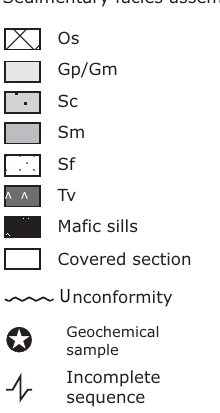
Figure 11. Synthetic diagram for the stratigraphy of the Imbert Fm in the Puerto Plata ophiolitic and Río San Juan complexes. See Fig. 2 for locations of sections and text for